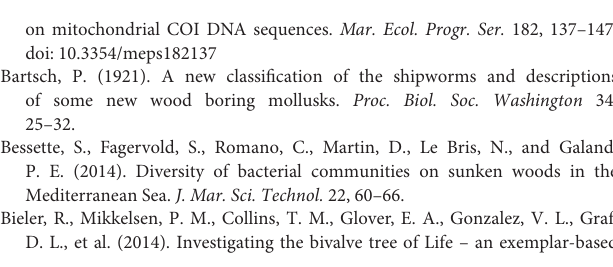
Supplementary Figure 1 | Bayesian Inference analysis (10,000,000 generations, sampling interval 1000 × ) based on COI sequences (388 bp). Statistical support (BI posterior probabilities > 0.85/RAxML 100 × bootstraps) is indicated on the nodes. Taxa names include locations (see Figure 1 for abbreviations) and identity of the specimens (see Supplementary Table S3 for GenBank accession numbers). Sampling locations are also indicated by color code. Supplementary Table 1 | List of primers. ∗ = PCR primer pairs; unmarked = internal primers. Annealing temperatures (Ta, ◦ C) modified for amplification steps depending on enzymes (see Supplementary Table S2 ). Supplementary Table 2 | List of enzyme polymerases and the PCR conditions used in this study. Supplementary Table 3 | Identity of the specimens used for each genetic analysis, and GenBank sequences and accession numbers. ∗ = outgroup species for tree